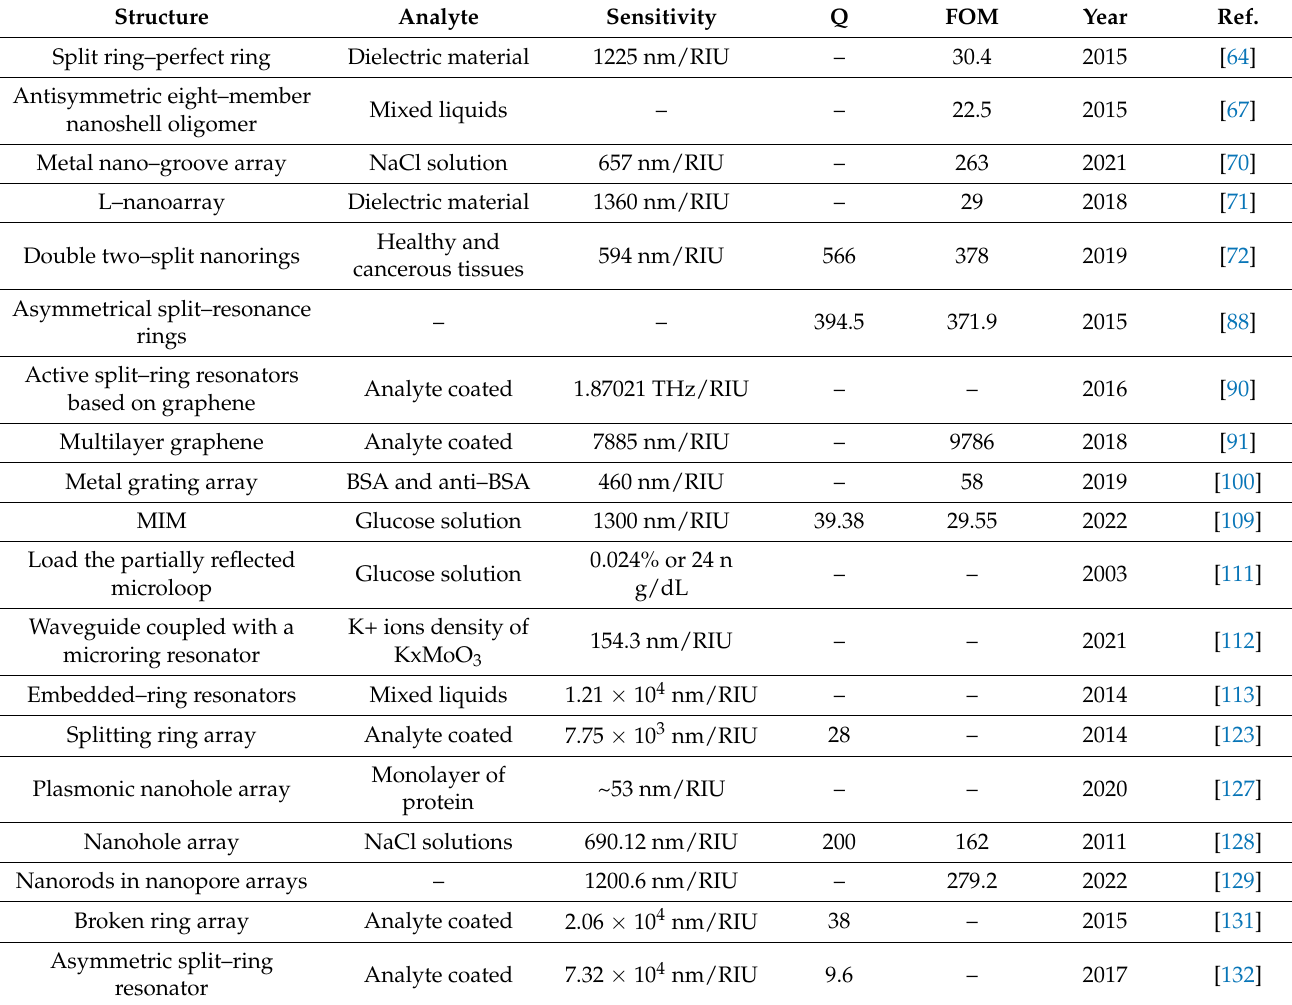
Table 1. Examples of Fano resonance